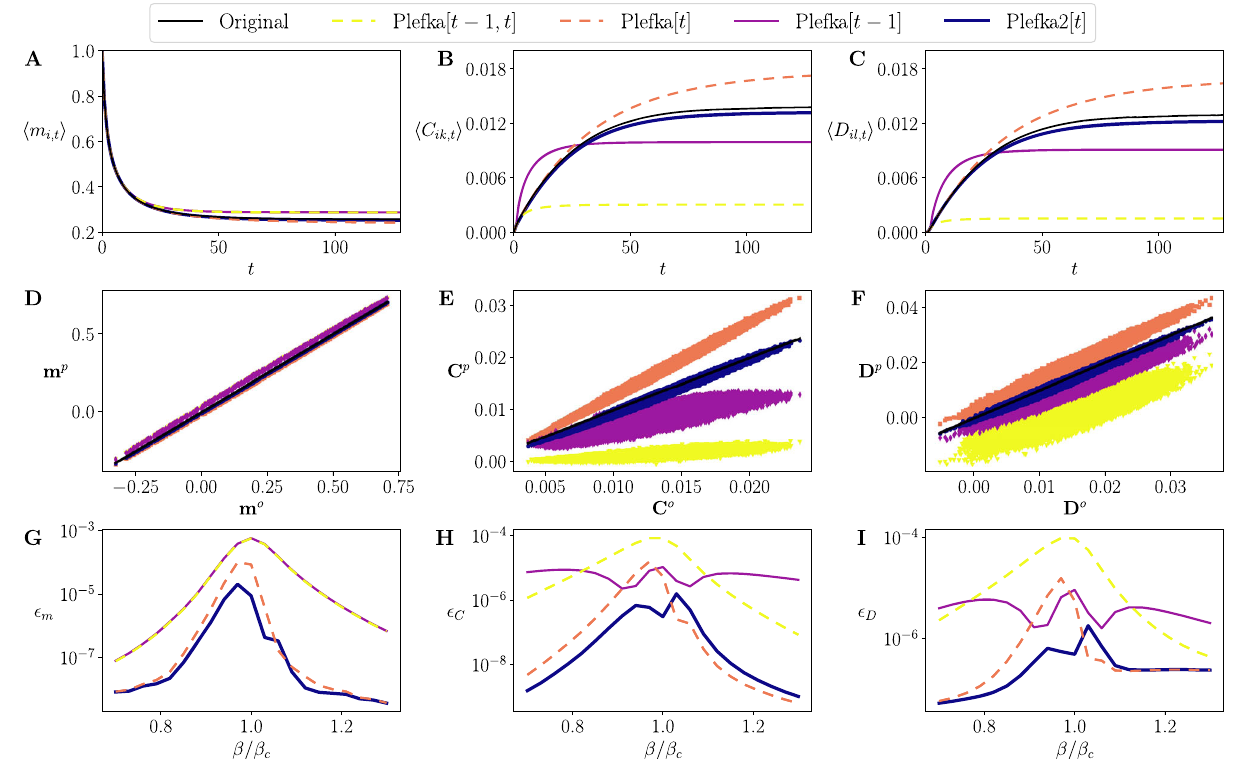
Fig. 3 Forward Ising problem. Top: Evolution of average activation rates (magnetizations) ( A ), equal-time correlations ( B ), and delayed correlations ( C ) found by different mean- fi eld methods for β = β c . Middle: Comparison of the activation rates ( D ), equal-time correlations ( E ), and delayed correlations ( F ) found by the different Plefka approximations (ordinate, p superscript) with the original values (abscissa, o superscript) for β = β c and t = 128. Black lines represent the identity line. Bottom: Average squared error of the magnetizations ϵ m ¼ hhð m o i ; t (cid:2) m p i ; t Þ 2 i hhð C o